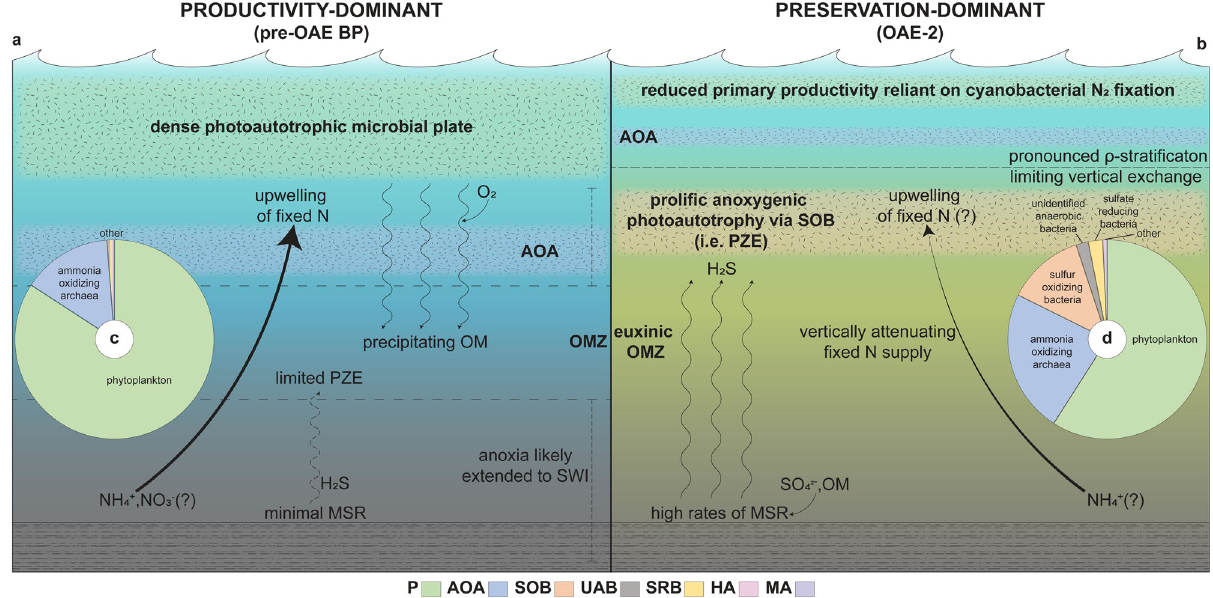
Fig. 5 Contrasting biogeochemical conditions between the pre-OAE BP and OAE-2. a , b Microbial ecology and water column conditions during the pre- OAE BP, re fl ecting high primary production of organic carbon ( a ) and OAE-2, characterized by relatively lower organic carbon production, but substantially enhanced biomass preservation ( b ). c , d Averaged fractional abundances of individual biomarkers throughout the pre-OAE BP ( c ) and OAE-2 ( d ). Biomarker source organisms are abbreviated as follows: phytoplankton (P), ammonia oxidizing archaea (AOA), sulfur oxidizing bacteria (SOB), unknown anaerobic bacteria (UAB), sulfate reducing bacteria (SRB), halophilic archaea (HA), methanogenic archaea